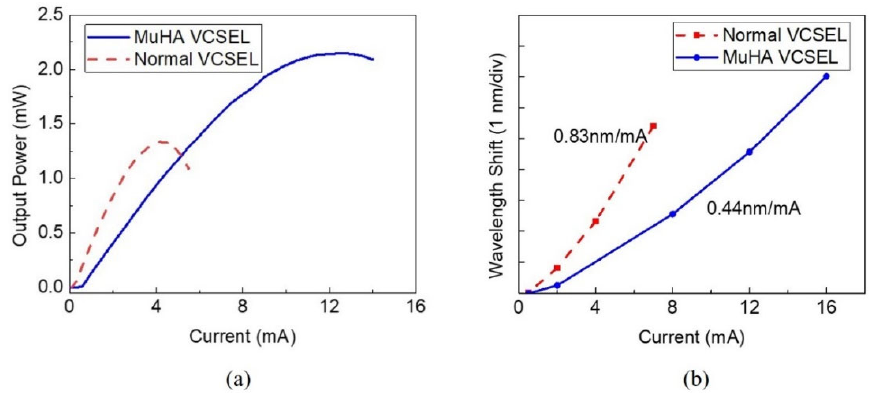
Figure 13. ( a ) Light-current of 940 nm normal VCSEL and 940 nm MuHA VCSEL. ( b ) The wavelength shifts of the normal VCSEL and the MuHA VCSEL. The oxide aperture areas of the two VCSELs are equal.